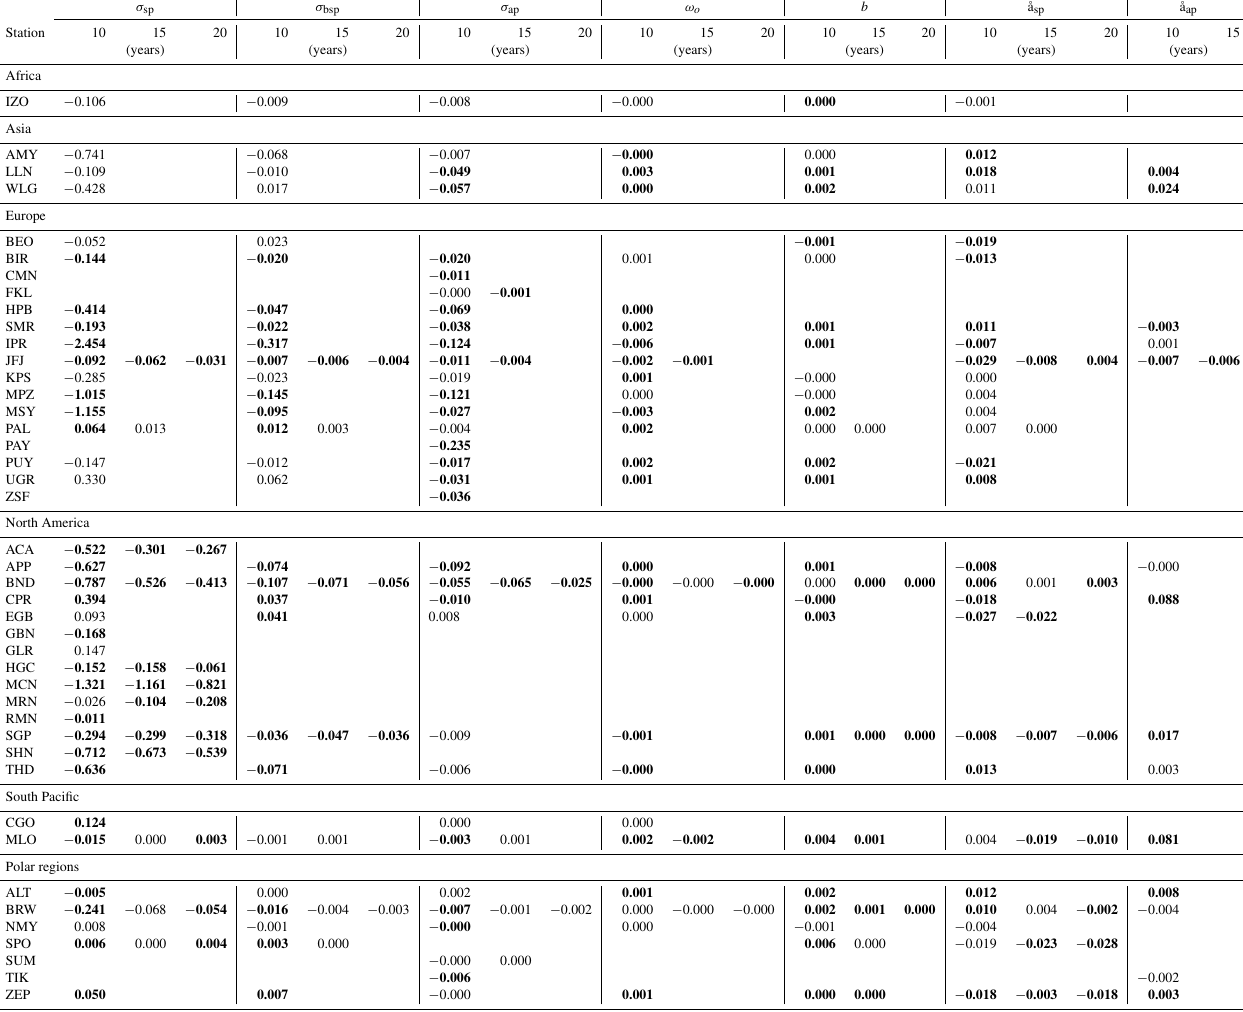
Table 2. MK trends for all parameters in units per year for the last 10, 15 and 20 years of measurements ending in 2016–2018. The ss trends are given in bold. Results in %yr − 1 are given in Table